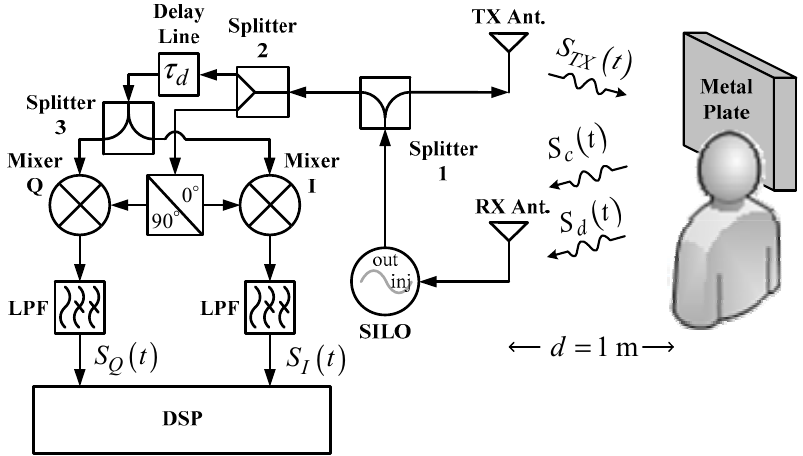
Figure 2. SIL radar for non-contact vital sign monitoring.